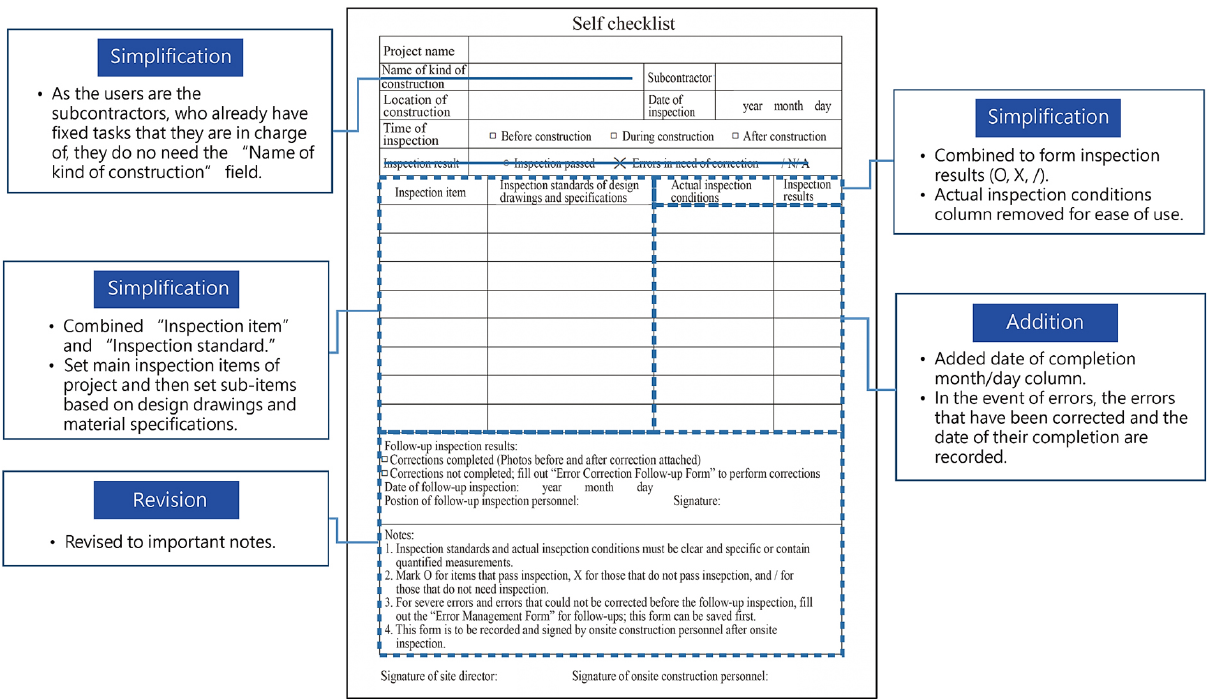
Figure 10. Example of refined checklist for private housing project